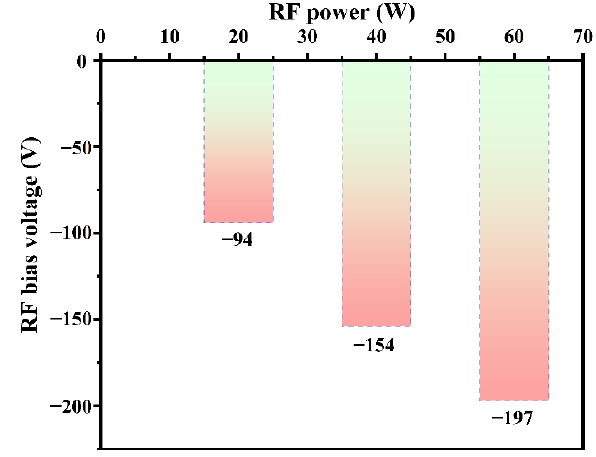
Figure 2. Correlation between RF bias and RF power.